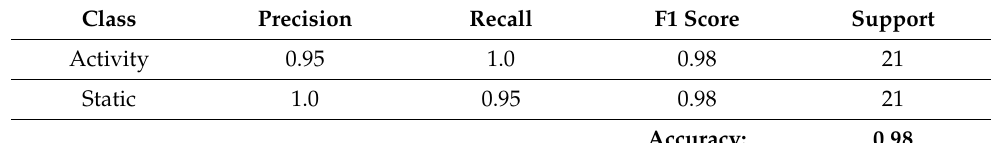
Table 3. Classificationstatistics in the second validation environment for OAMD algorithm.